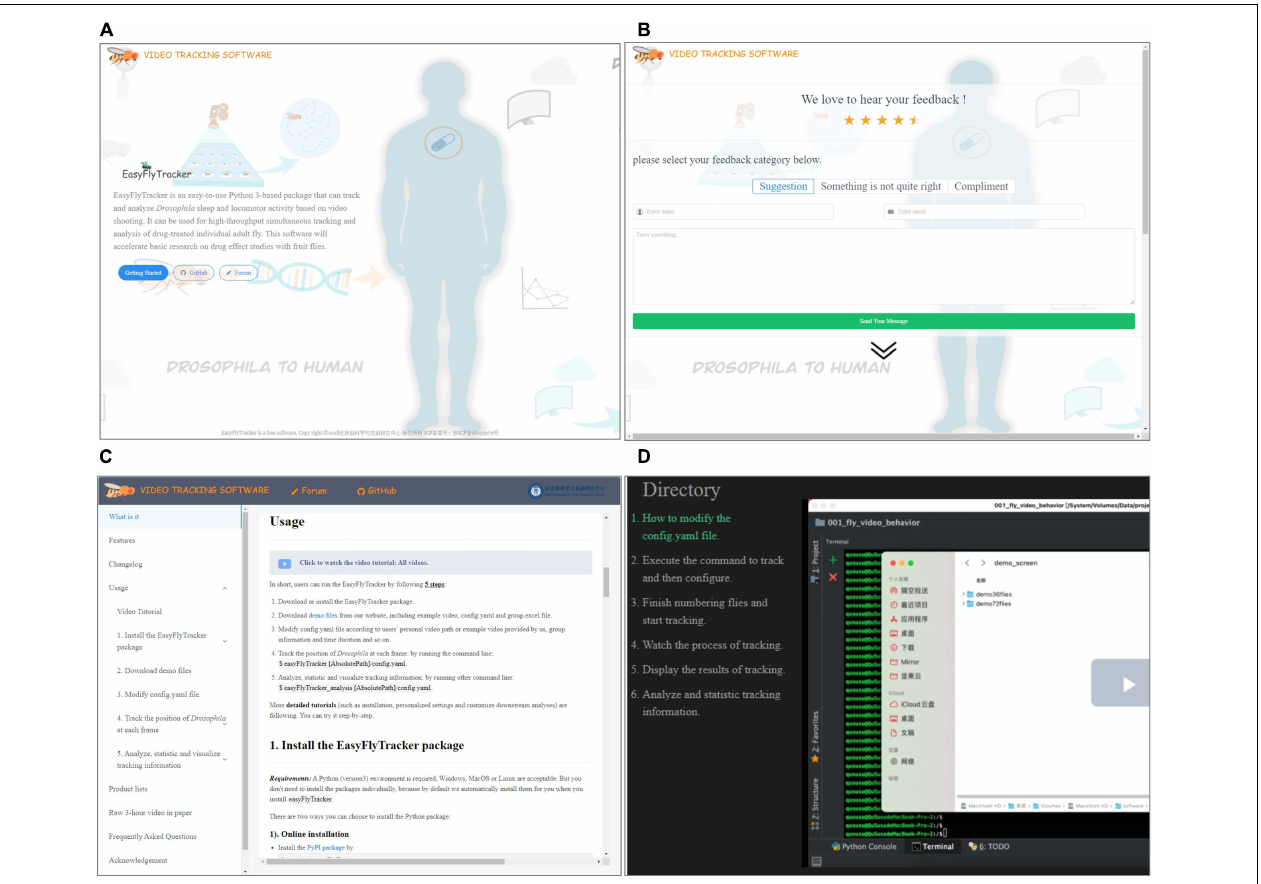
FIGURE 3 | The website of EasyFlyTracker. (A) Home page. (B) Feedback page where users can add comments and suggestions for better upgrade interaction. (C) Detailed usage example. (D) Step-by-step video